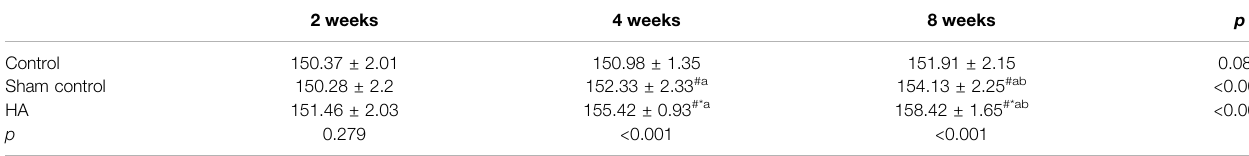
TABLE 2 | Quantitative analysis of BMP-2 expression at different time points.